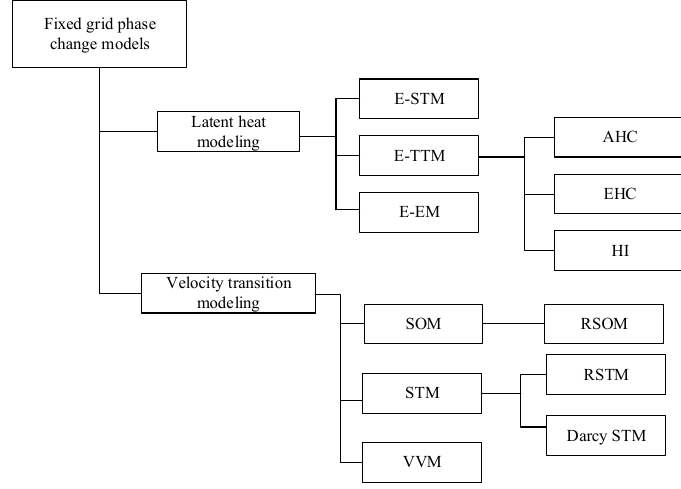
Figure 9. Classification of fixed grid phase change models.